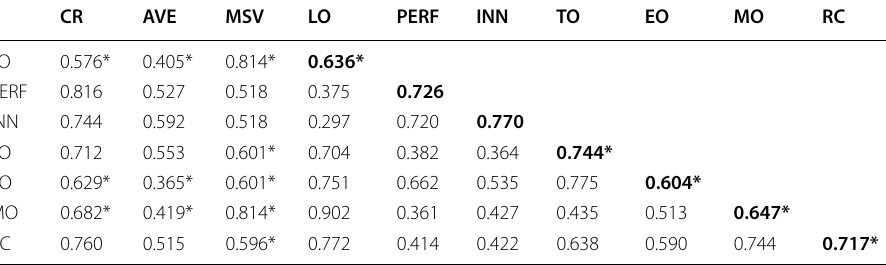
*Values below recommended criteria Source: